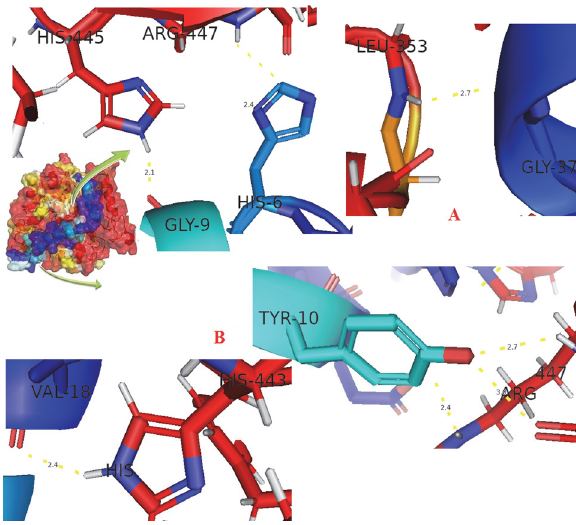
Figure 6. The InterEvDock2 model results of Aggregatin and Aβ42 peptides. The docking complex is represented in a surface rep- resentation, colored by (Aβ42 in blue color and Aggregatin in red) A.) Aggregatin(TYR303) interacts with the residue HIS6 of Aβ42 having the highest energy score. B.) Aggregatin(ASP359) interacts with HIS13, GLN442 with PHE20, and HIS443 with LEU17. C.) Aggregatin(VAL333) interacts with HIS13, and ALA365 with TYR10 in the N-terminal domain of Aβ1-42 peptide. The highest score belongs to the model in section A (see Table 2).